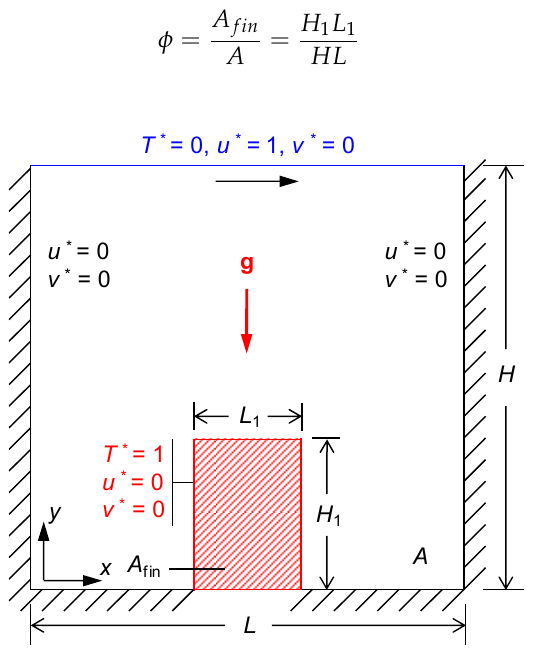
Figure 1. Schematic diagram of the mixed convective flow domain with an intruded rectangular fin in its bottom center and various boundary conditions for the numerical simulation.